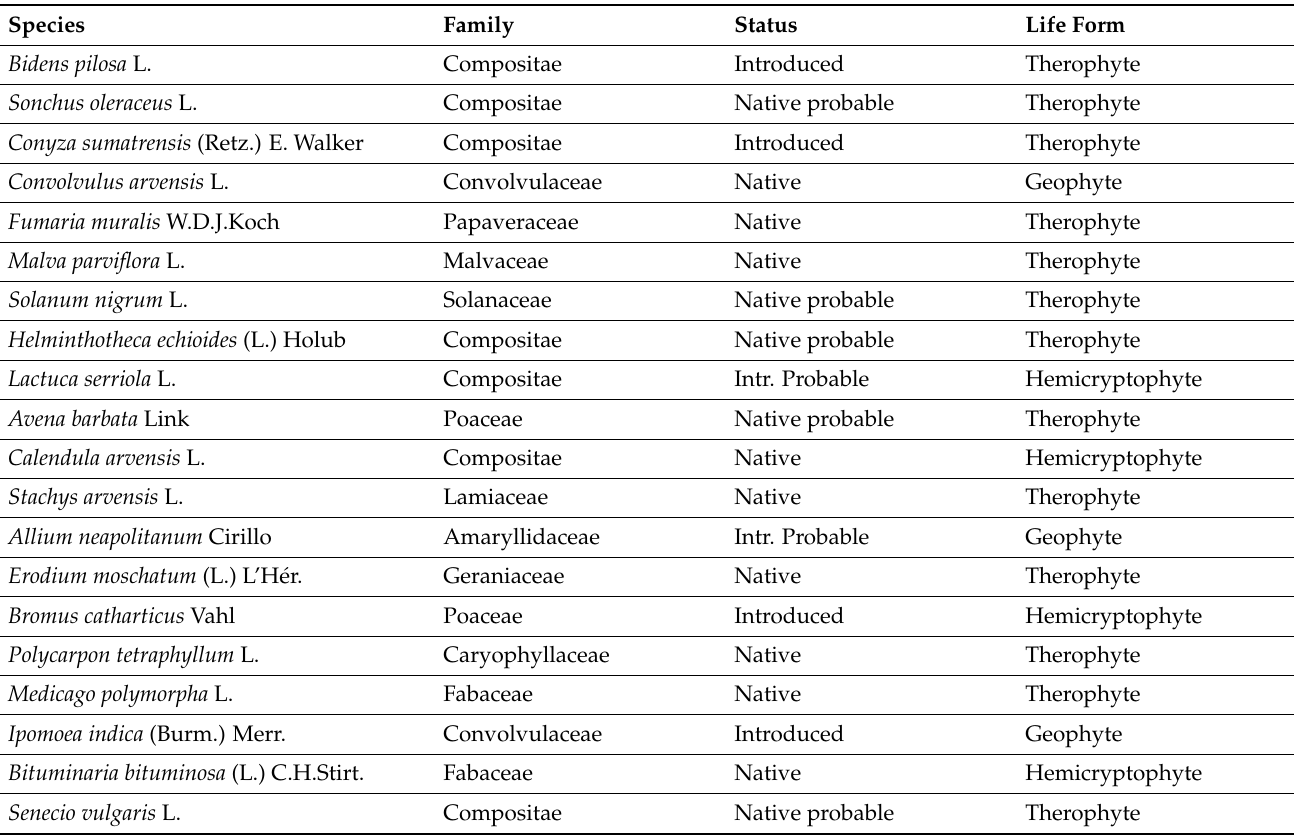
Table 6. Ranking of the QV agrosystem 20 most surveyed plant species and their respective taxonomic family, ecological status, and life form classification during the project’s